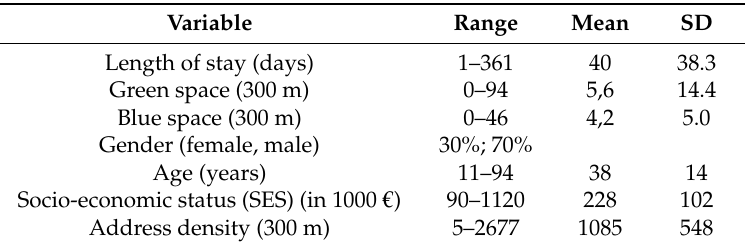
Table 1. Descriptive statistics of the study population.